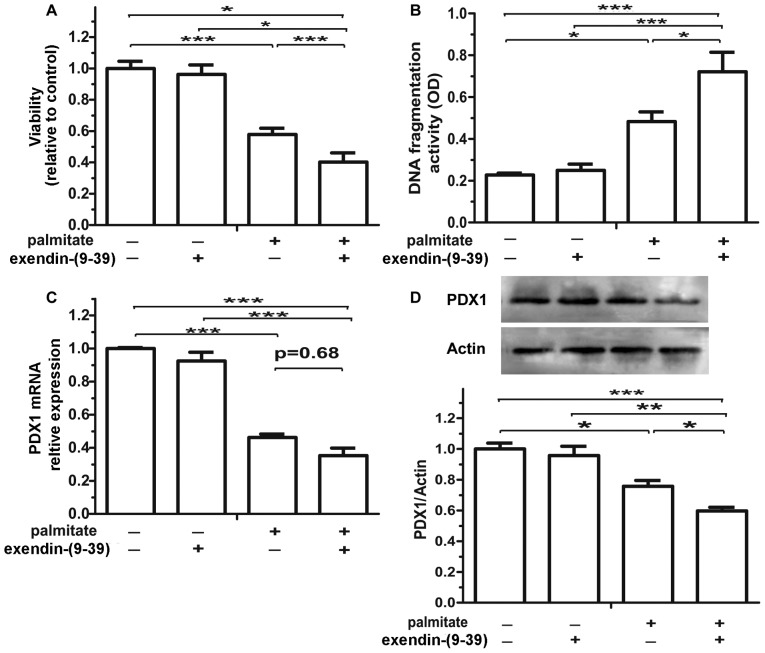
Glucagon-like peptide-1 receptor (GLP-1R) inhibition exacerbates the detrimental effects of palmitate. Isolated islets were pre-treated with the GLP-1R antagonist, exendin-(9-39), (0.5 µmol/l) for 2 h, followed by exposure to 0.5 mmol/l palmitate for 48 h. Islet (A) viability (detected by MTT assay) and (B) apoptosis (determined by examining histone-associated DNA fragments), and pancreatic duodenal homeobox 1 (PDX1) (C) mRNA (detected by qPCR) and (D) protein levels (detected by immunoblot analysis). n=3 separate islet preparations; *p<0.05; **p<0.01; ***p<0.001.